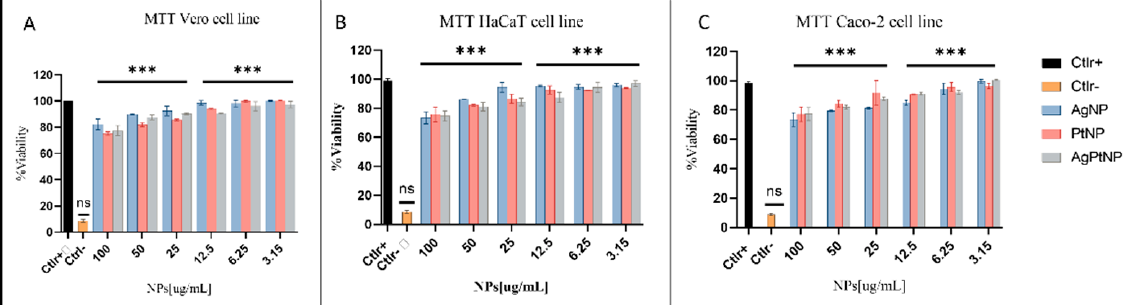
Figure 11. MTT assay on different cells lines. ( A ) Vero cells ( B ) HaCaT cells and ( C ) Caco-2 cells. Not treated cells were used as positive control (Ctlr+), while DMSO was used as negative control (Ctlr − ). Data are means of three independent experiments ***: p < 0.001; ns: not significant, relative to Ctlr+.